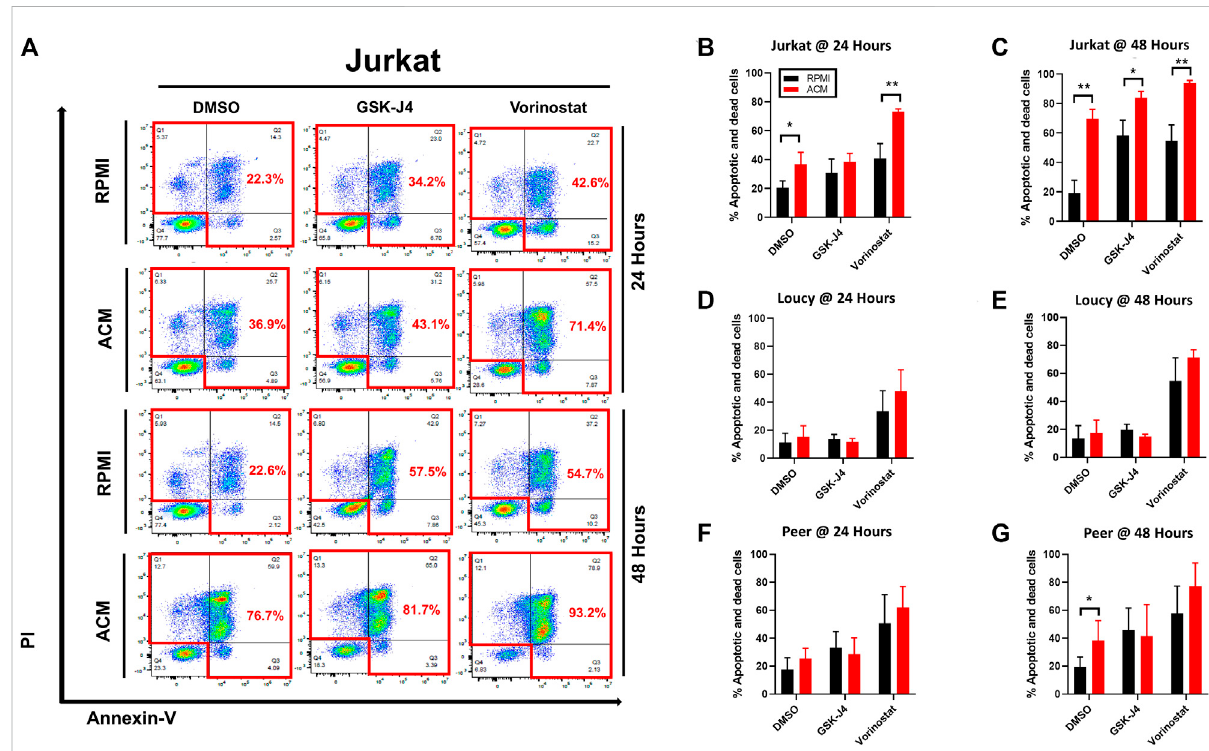
FIGURE 7 Adipocytesecretomeaugmentsthecytotoxiceffectsofepigeneticmodifyingdrugs.HumanT-ALLcells(Jurkat,Loucy,andPeer)werecultured in either RPMI or ACM with or without the epigenetic modifying drugs GSK-J4 or vorinostat for 24 and 48 h. T-ALL cell death was determined using Annexin-V/PI staining followed by fl ow cytometric analysis at both time points. (A) Annexin-V/PI fl ow cytometry data are shown for a representative ofthreeindependentexperiments. (B – G) Quantitativedatafromcombinedexperiments( n ≥ 3)arepresented.AStudent ’ s t -testwasperformed to determine statistical signi fi cance in (B – G) . * p < 0.05 and ** p <